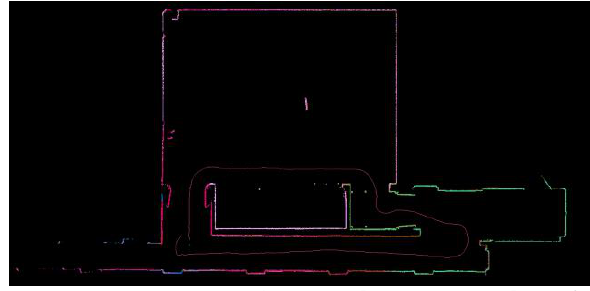
Figure 6. iMMS processed SLAM solution trajectory loop of corridor in Viametris PPIMMS